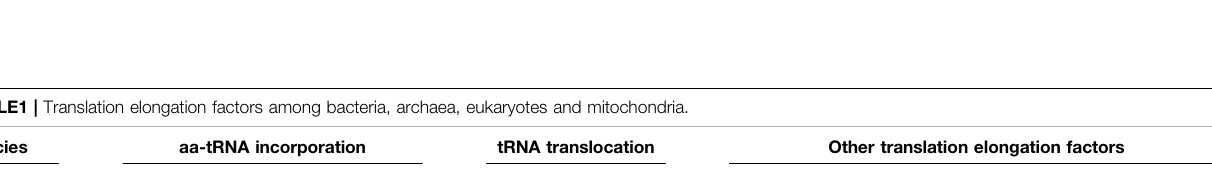
TABLE1 | Translation elongation factors among bacteria, archaea, eukaryotes and mitochondria. Species aa-tRNA incorporation tRNA translocation Bacteria